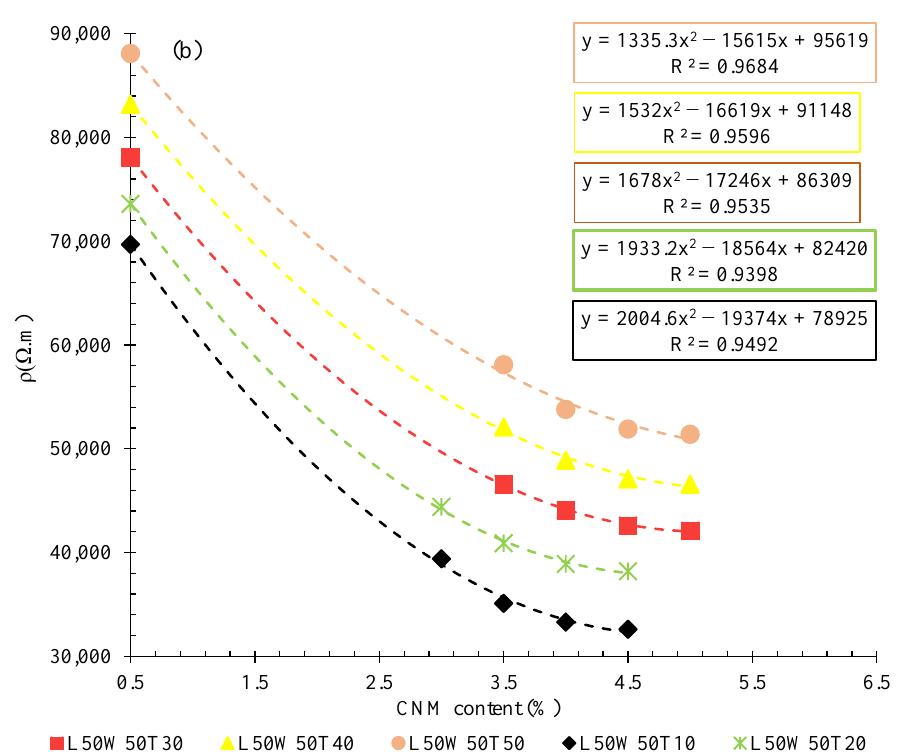
Figure 10. Volumetric electrical resistance of CNT/GNP reinforced specimens with: ( a ) different width, ( b ) different thickness.